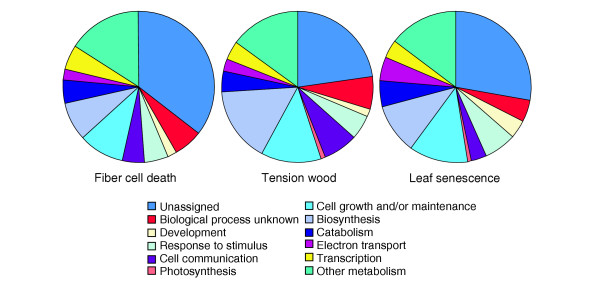
Assignment of gene ontologies to ESTs in the cDNA libraries representing fiber death, tension wood and leaf senescence in the POPULUSDB.